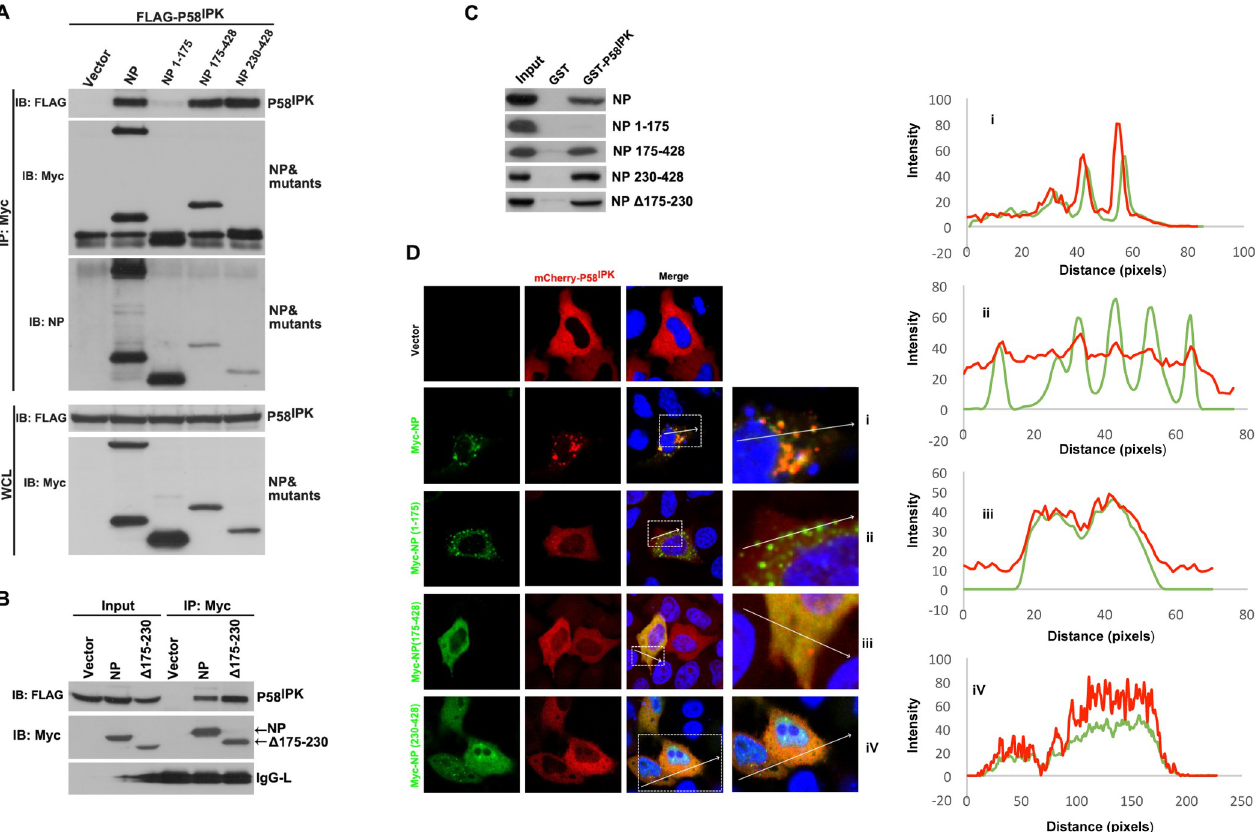
Fig 3. NP harbors a P58 IPK binding site at the C-terminus. A. HEK293T cells were co-transfected with plasmids expressing FLAG-P58 IPK along with either wild type Myc-NP or NP truncation mutants NP1-175 or NP175-428 or NP230-428 fused to the Myc tag. Western blot analysis of the immunoprecipitated material or whole cell lysate (WCL) was carried out using appropriate antibodies. The western blot analysis of the immunoprecipitated material using anti-Myc antibody did not show NP1-175 and NP230-428 mutants due their size coinciding with light chain antibody (2 nd from top). The blot was re-probed using anti- NP antibody, which showed the mutants NP1-175 and NP230-428 (3 rd from top). The lower band in NP lane shows a degradation product. B. The experiment shown in panel A was repeated here to test another NP mutant lacking the RNA binding domain (NP Δ 175–230) and results were compared with wild type NP. C . Bacterially expressed and purified GST or GST-P58 IPK was immobilized on Glutathione Sepharose beads. Beads were washed and incubated with HEK293T cell lysates containing wild type NP or NP mutants. The material eluted from washed beads was examined by western blot analysis using anti-Myc antibody. D . HeLa cells were cotransfected with plasmids expressing mCherry-P58 IPK along with either wild type NP or NP truncation mutants fused with Myc tag. The Myc tagged proteins were probed with anti-Myc antibody and visualized using a secondary antibody conjugated with Alexa Fluor 488. The boxed area in the merge panels were magnified and presented sidewise with labels I, ii, iii and iv. Using the ImageJ software, a line was drawn through the two or more puncta and the fluorescence intensity under the line is represented in the sidewise graphs corresponding to panels I, ii, iii and iv, as shown. The red line is the fluorescence intensity of mCherry-P58IPK, and the green line represents the intensity of the Alexa Fluor 488. Unlike panel ii, the red and green fluorescence signals in panels I, iii and iv show strong colocalization as evidenced by the fact that both signals are significantly above the background and increase at the same